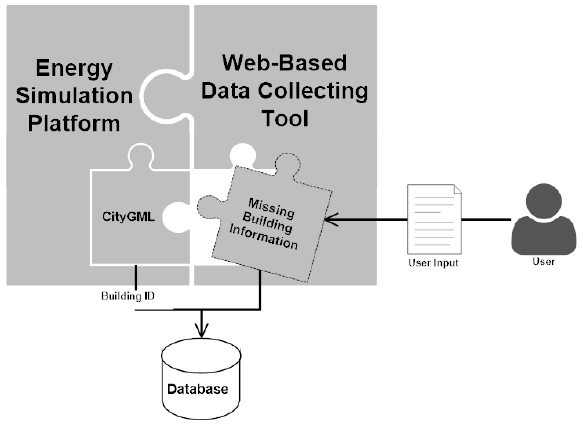
Figure 1. An illustration of how the data collecting tool feeds the energy simulation platform with building data that completes the existing building dataset.